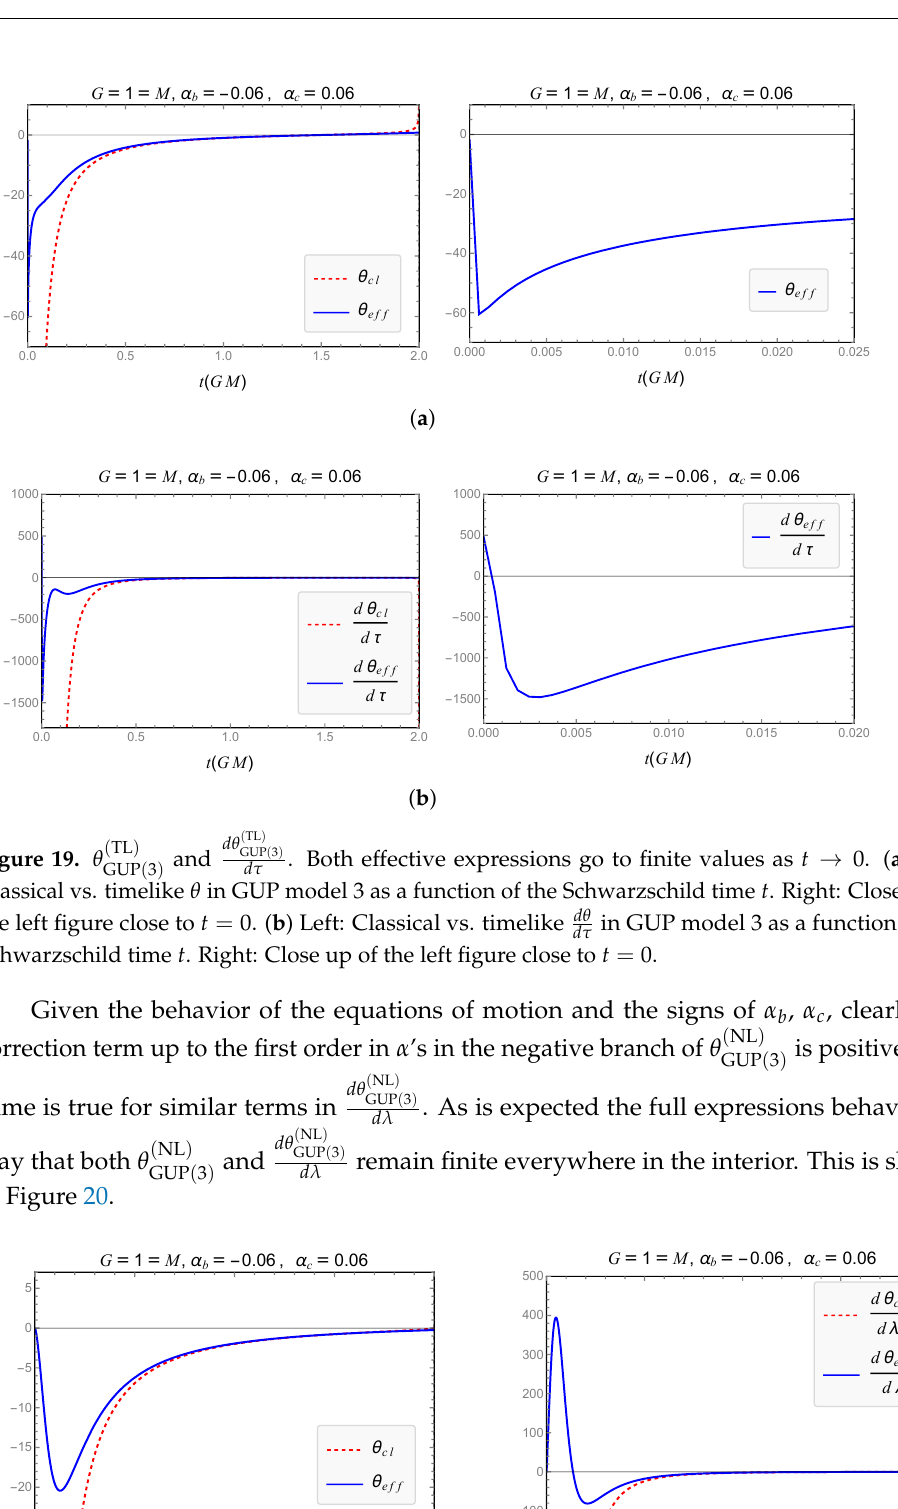
d θ ( NL ) ( NL ) GUP ( 3 ) Figure 20. θ and . Both effective expressions vanish as t → 0. ( a ) Classical vs. null θ in d λ GUP ( 3 ) GUP model 3 as a function of the Schwarzschild time t . ( b ) Classical vs. null d θ function of the Schwarzschild time t